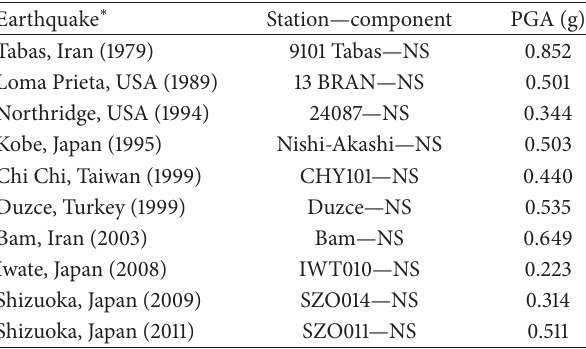
Table 1: List of the selected input ground